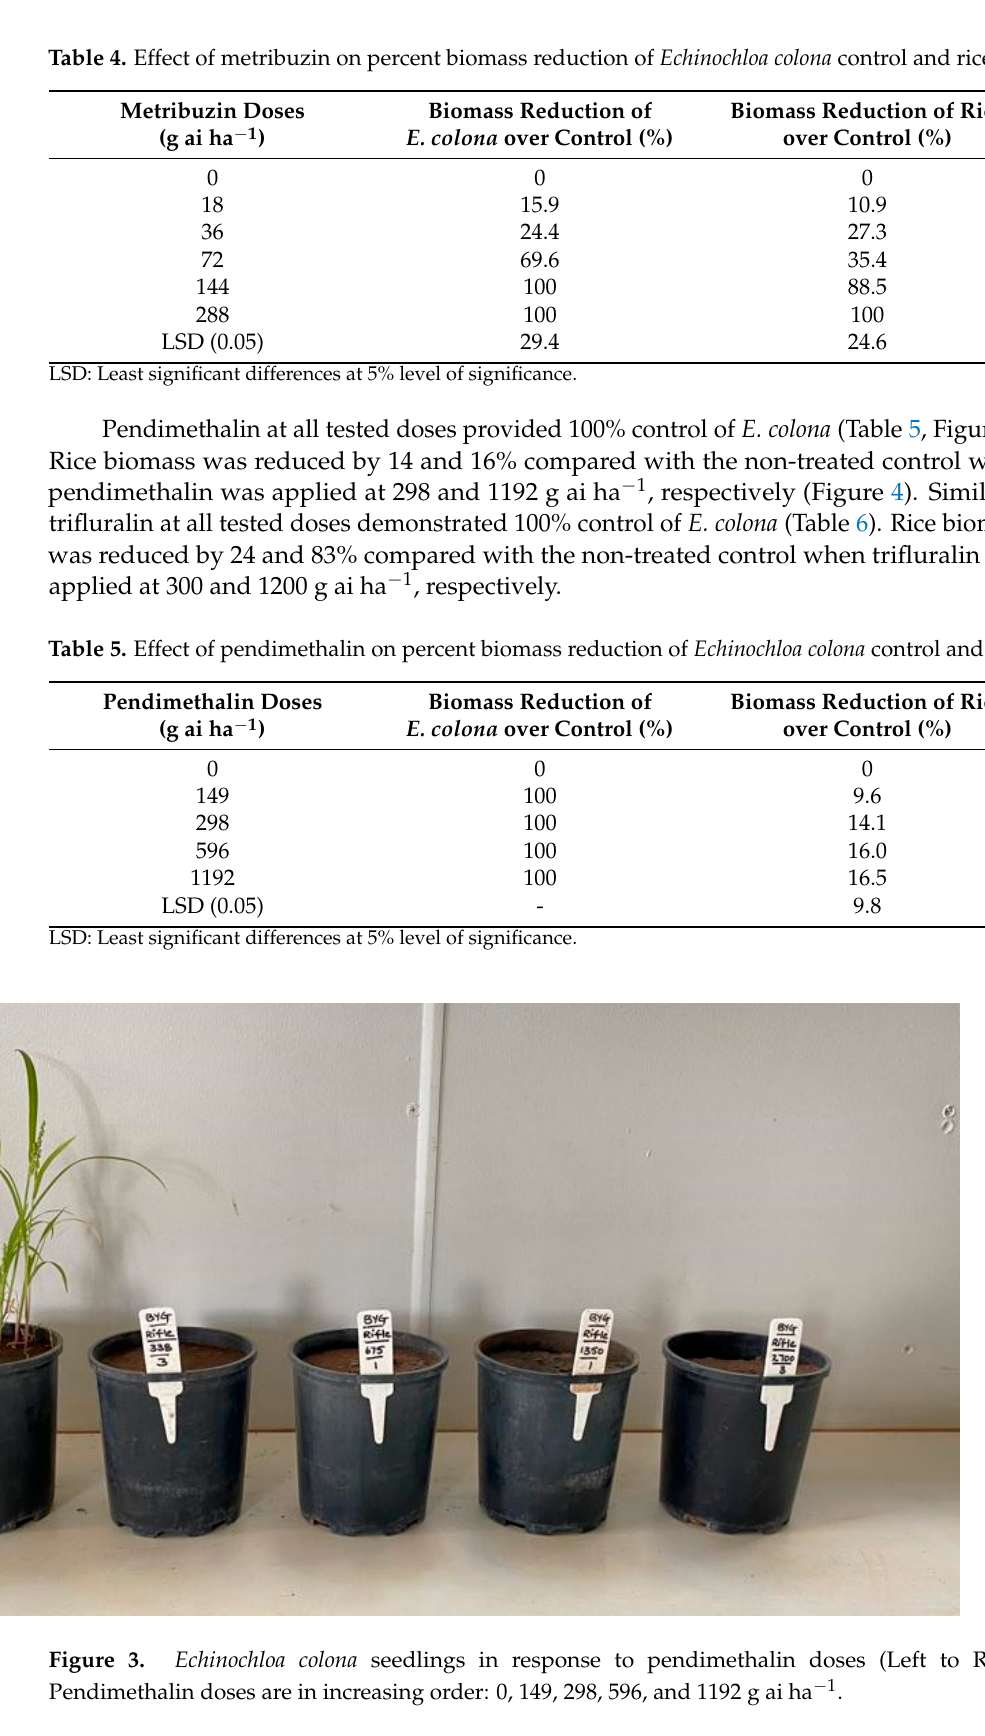
Figure 4. Rice seedlings in response to pendimethalin doses (Left to Right: Pendimethalin doses are in increasing order: 0, 149, 298, 596, and 1192 g ai ha − 1 . This study suggests that pendimethalin and flumioxazin effectively controlled E. colona and were safe for use on the rice plants. Trifluralin also provided effective control